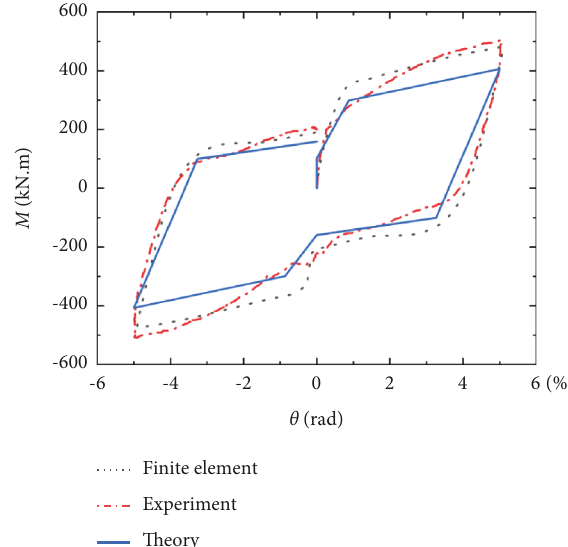
Figure 6: The comparison of experimental, theoretical, and FEM